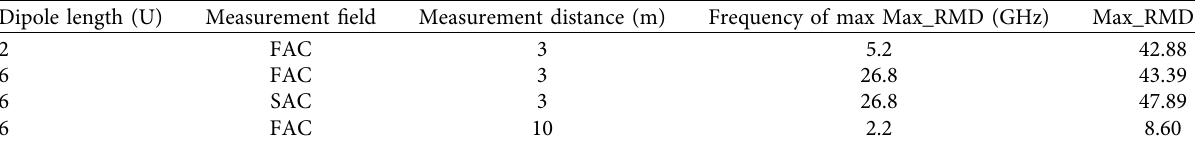
Table 1: Summary of calculation results.